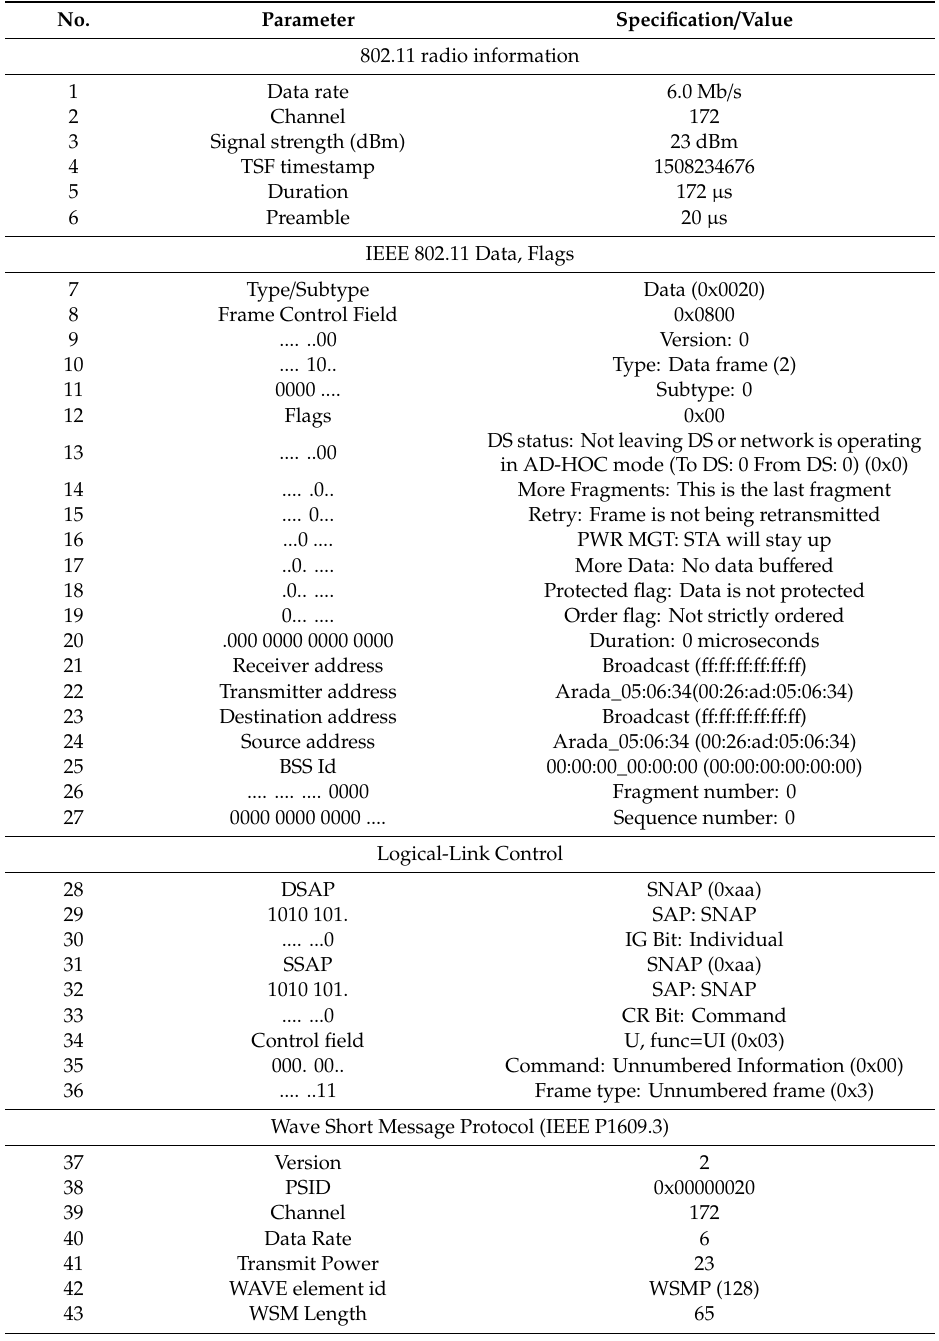
Table 2. Wave Short Message Protocol (WSMP)